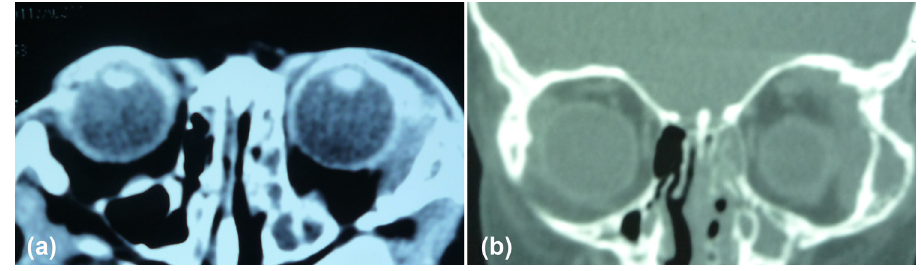
Figure 2: The radiological fi ndings of the 2 - year - old girl with an orbital mass. ( a ) Orbital axial CT showing the soft tissue mass on the lateral orbital rim of the left eye; ( b ) orbital coronal CT in the bone window showing the soft tissue mass on the lateral superior orbital rim of the left eye, with bone destruction in the lateral wall of the left orbit.